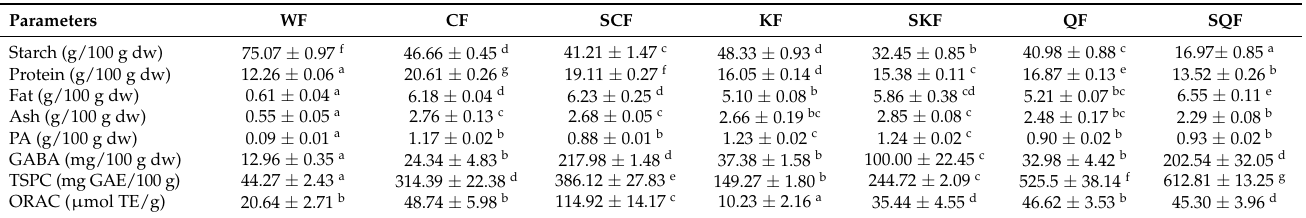
Table 1. Chemical composition (expressed as dry weight, dw) of cañihua, kiwicha, and quinoa flours from wholegrains and sprouted